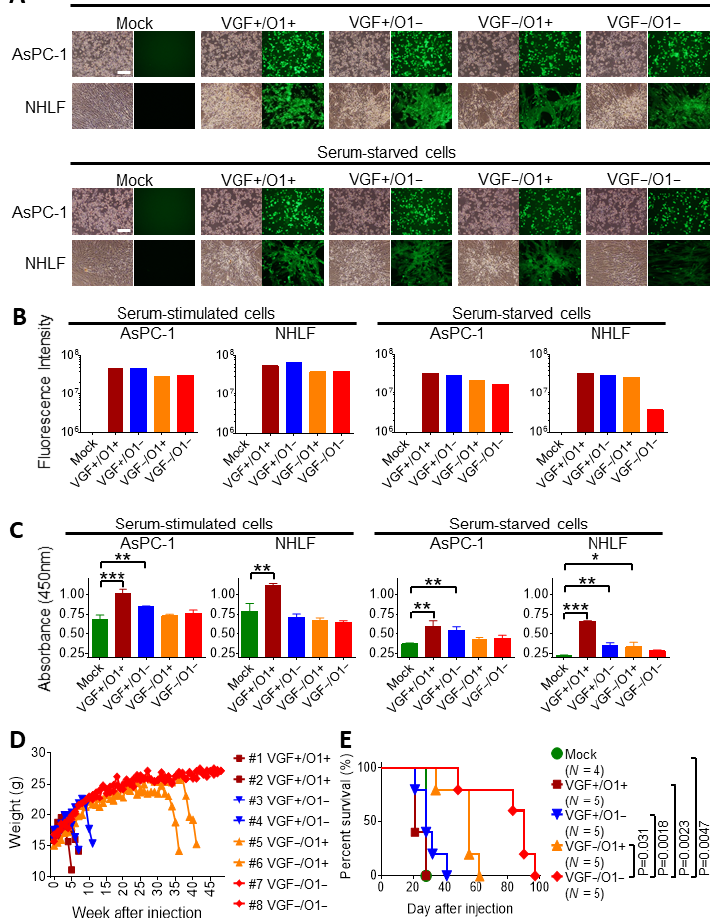
Figure 2. Vaccinia growth factor ( VGF )- and/or O1 -deleted mitogen-activated protein kinase-dependent recombinant vaccinia viruses (MDRVVs) are highly attenuated in normal cells but retain their therapeutic replication. The human pancreatic cancer cell line (AsPC-1) or normal human lung fibroblast (NHLF) cells were infected with each recombinant virus at a multiplicity of infection (MOI) of 1 under serum stimulation or starvation conditions, and were cultured for 30 h. ( A ) Bright-field (left) and EGFP (right) representative images of AsPC-1 and NHLF cells are shown. Scale bar, 500 µ m. ( B ) The fluorescence intensity in EGFP images of ( A ) was measured using Hybrid Cell Count (n = 1). ( C ) The levels of phosphorylated ERK1/2 (pERK1/2) were evaluated. Data are presented as the mean ± SD (n = 3). * p < 0.05, ** p < 0.01, *** p < 0.001 (one-way ANOVA and the Bonferroni test). ( D ) SCID mice were injected intraperitoneally with 1 × 10 6 plaque-forming units (PFUs) of each recombinant virus, and changes in body weight were observed for 48 weeks (n = 2). ( E ) BxPC-3 cells stably expressing Renilla luciferase were injected intraperitoneally into SCID mice on day 0. On day 8, the mice received a single intraperitoneal injection of each recombinant virus (1 × 10 6 PFU). Survival curves of mice were generated by Kaplan–Meier analysis (n = 4–5). p values were derived by log-rank